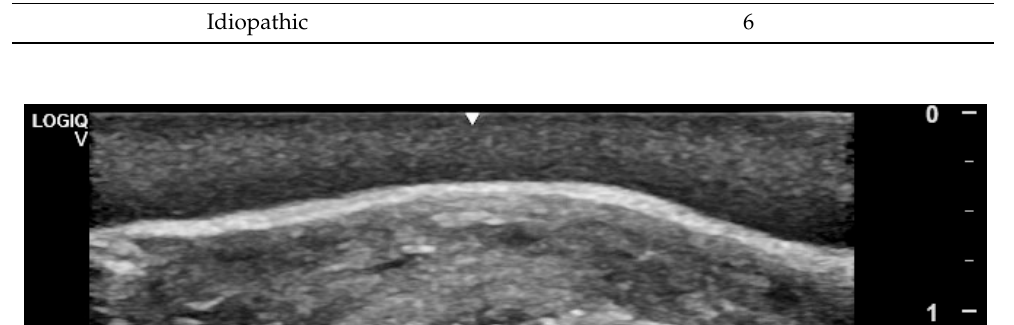
Figure 7. Ultrasonographic appearance of suture exostosis with central sequester formation. Note the thickened periosteum, subcutaneous tissue and skin.